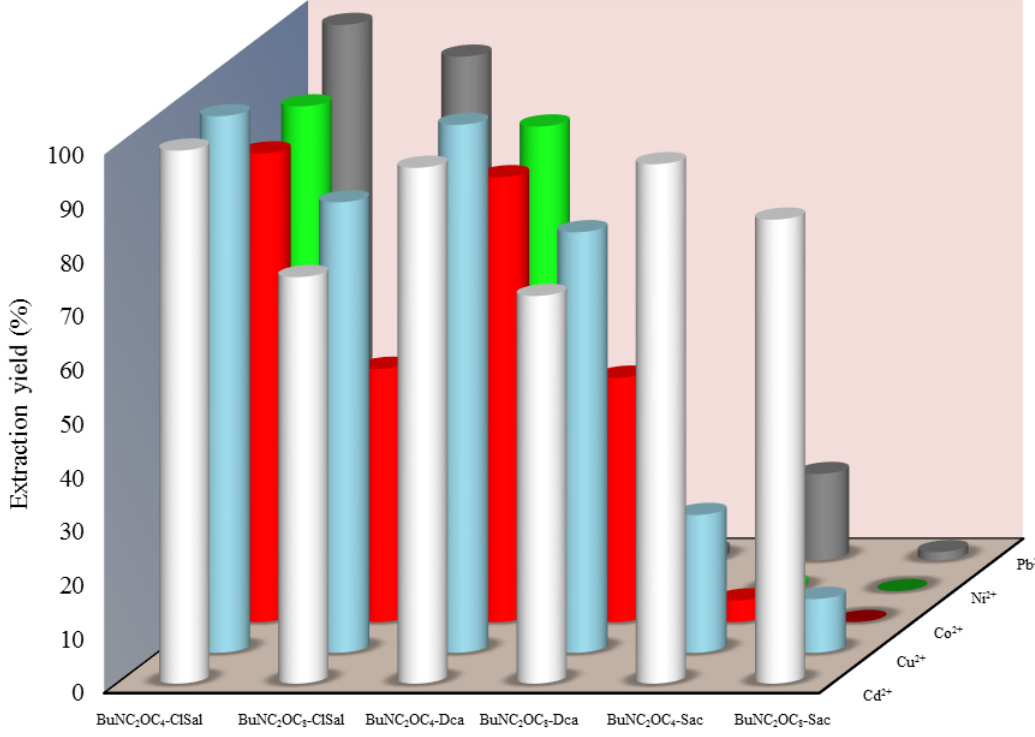
Figure 3. Extraction yields (%E) for metal aqueous nitrate salt with BuNC 2 OC 4 (C8)-Sac, BuNC 2 OC 4 (C8)-Clsal and BuNC 2 OC 4 (C8)-Dca. C metal = 0.05 mol L −1 ; V w = 2 mL; m Il = 0.5 g.